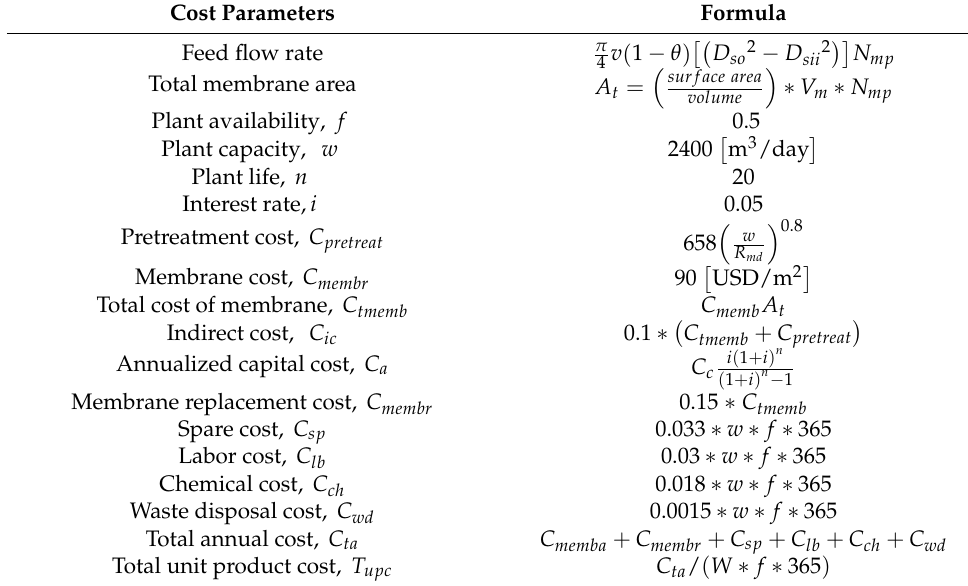
Table 3. MD cost estimation